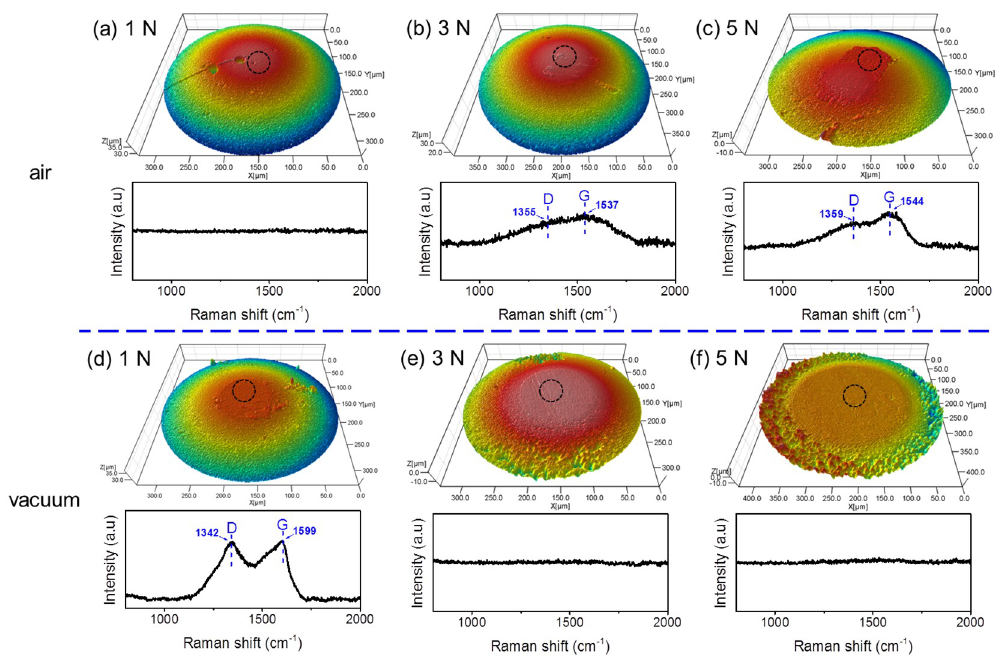
Figure 5. Three-dimensional images of (top) Al 2 O 3 balls and (bottom) Raman spectra in contact regions on ball surfaces after sliding 6000 cycles in humid air ( a–c ) and vacuum ( d–f ). Loads were 1, 3, and 5 N, respectively.